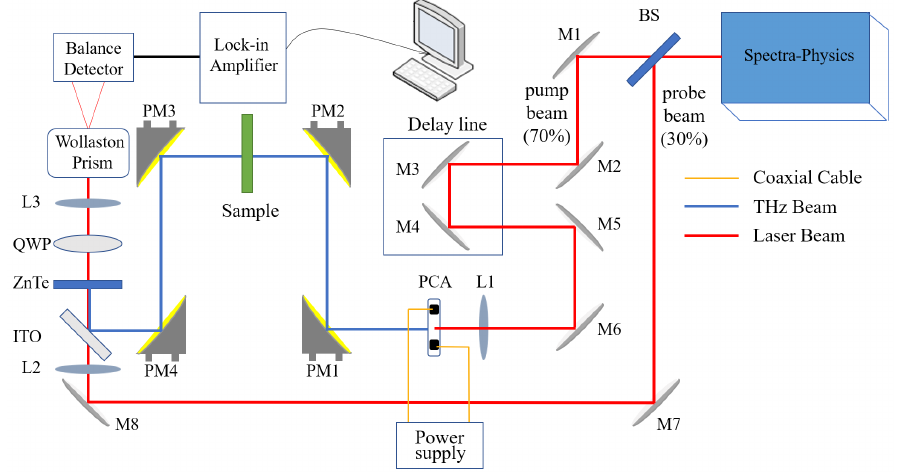
Figure 2. Schematic of THz-TDS system with a sample cell. BS: beam splitter; M: mirror; L: lens; PM: parabolic mirrors; ITO: indium tin oxide; QWP: quarter waveplate; PCA: photoconductive